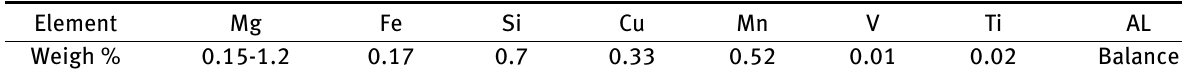
Table 3: Experimental factors and their levels. Factor